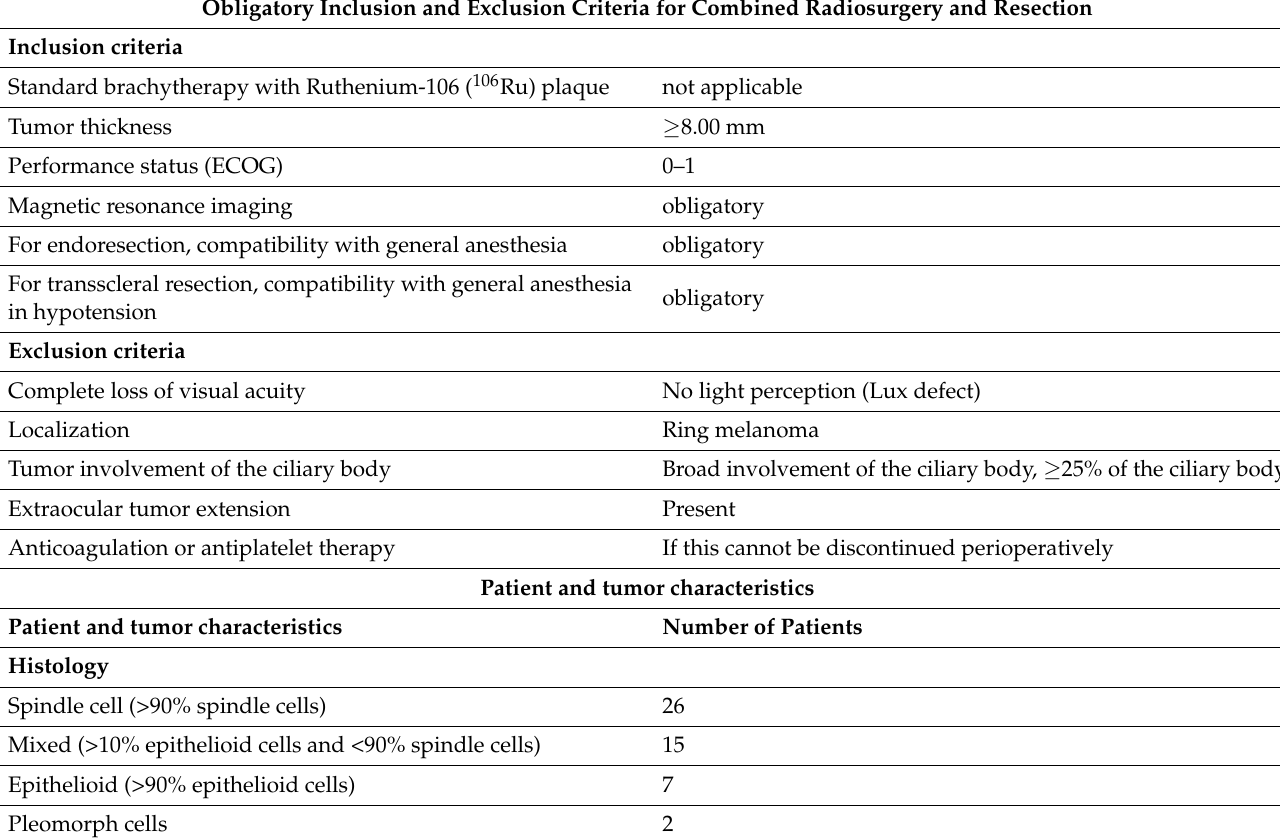
Table 1. Main Inclusion and Exclusion Criteria, Patient and tumor